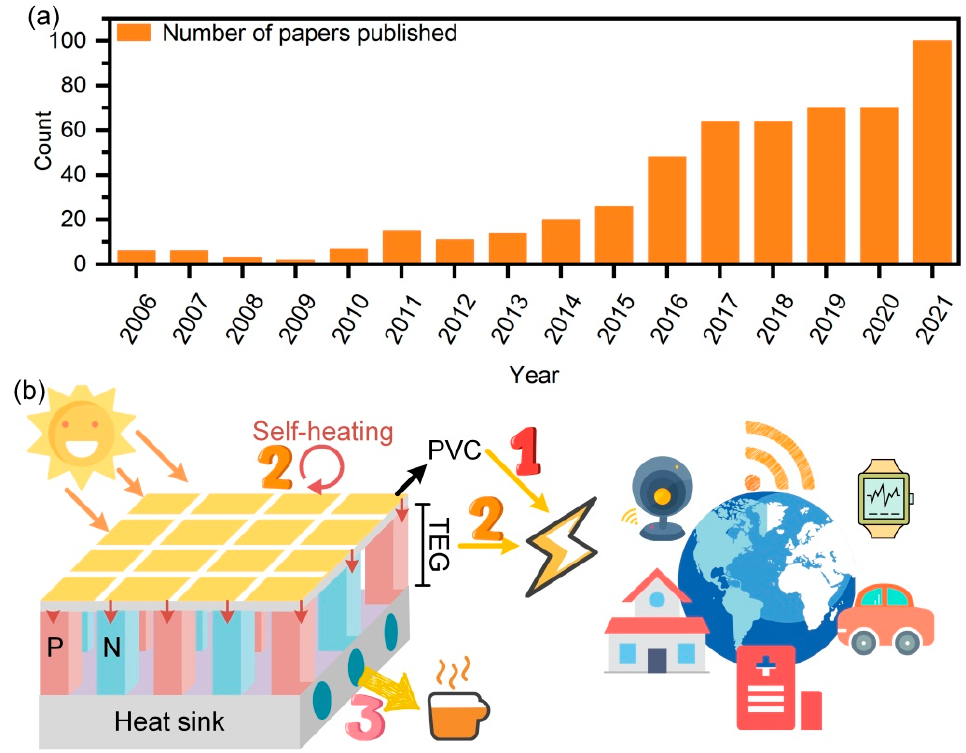
Figure 7. ( a ) The number of papers published on PVC–TEG hybrid (tandem) systems organized by year. Source: Web of Science. Clarivate Analytic Data, https://www.webofscience.com/wos/, accessed on 17 October 2022. ( b ) Schematic diagram of energy flow and application for the hybrid system.